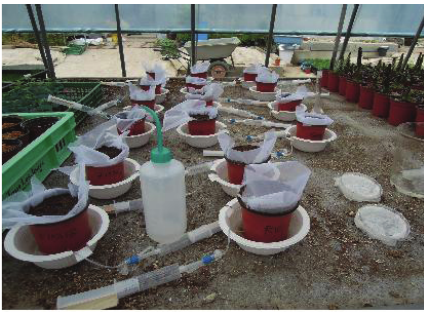
Figure 2: Experimental apparatus to collect pore water from micro- cosm test.